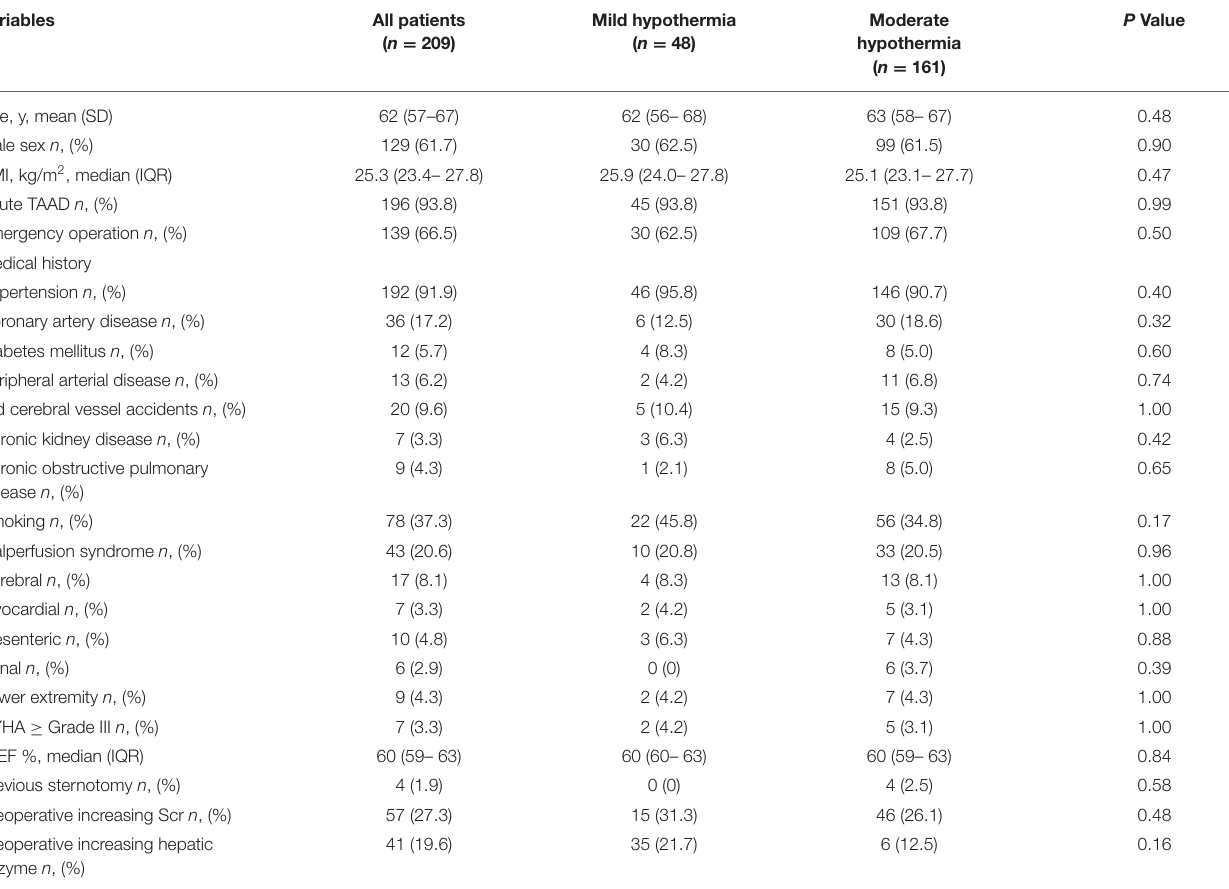
TABLE 1 | Baseline